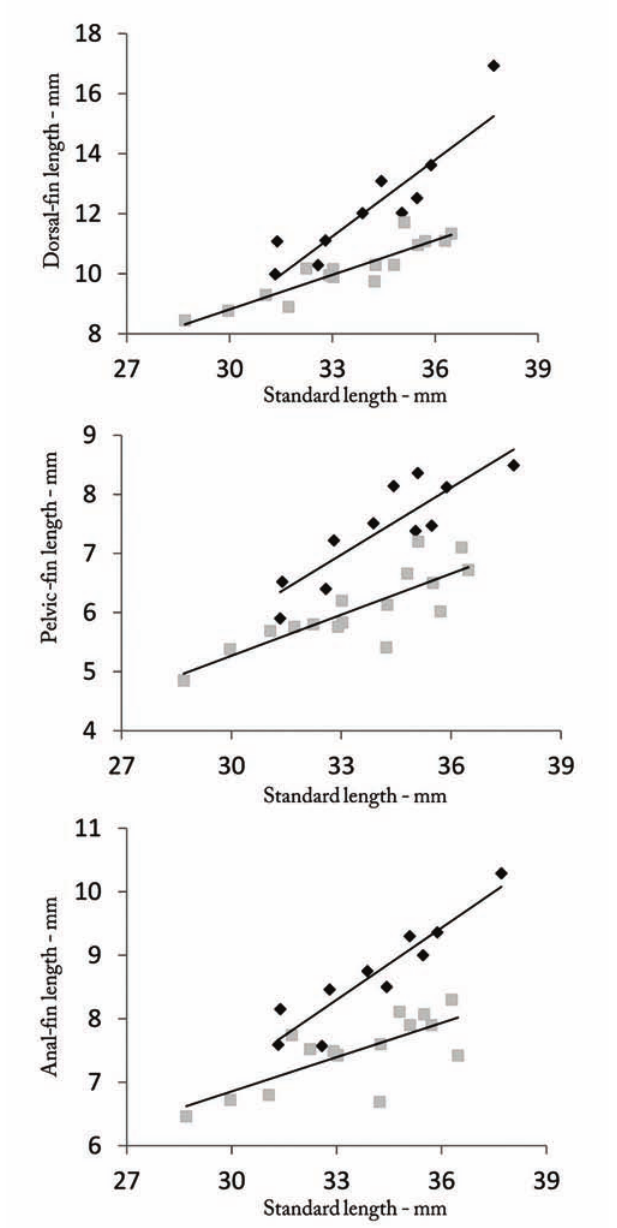
Fig. 3. Fin lengths as function of standard length in males (dark diamonds) and females (light squares) of Hemigrammus ataktos : (a) dorsal fin, (b) pelvic fin, and (c) anal